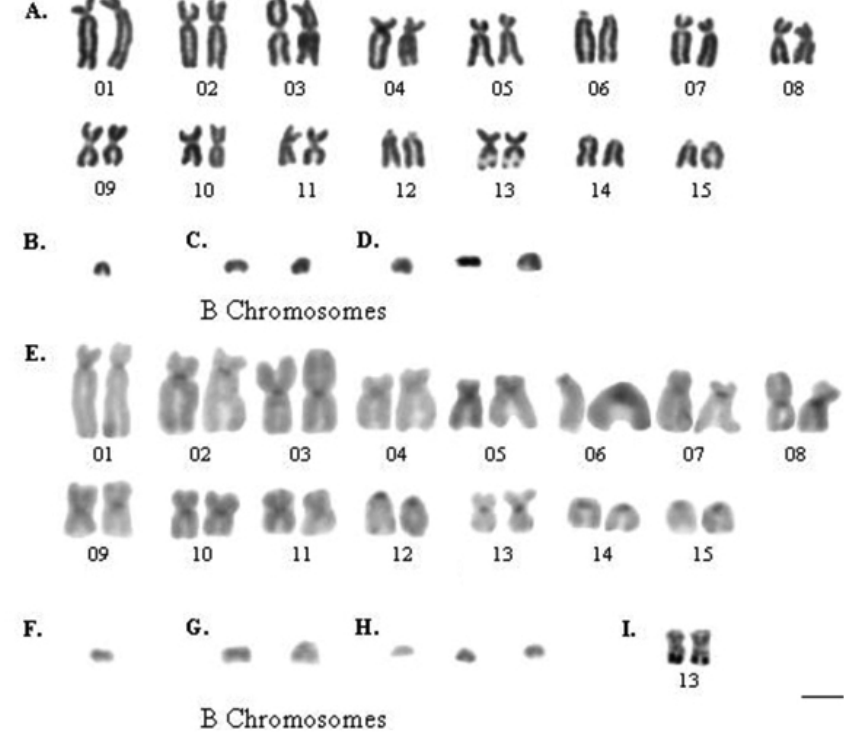
Figure 1 - Karyotype of D. nanus after Giemsa staining (A) and C-banding (E). One, two or three small telocentric B-chromosomes were observed in metaphasesfromsomespecimensafterGiemsastaining(B-D)andC-banding(F-H).Ag-NORsweredetectedonchromosomepair13(I).Bar=5 µ